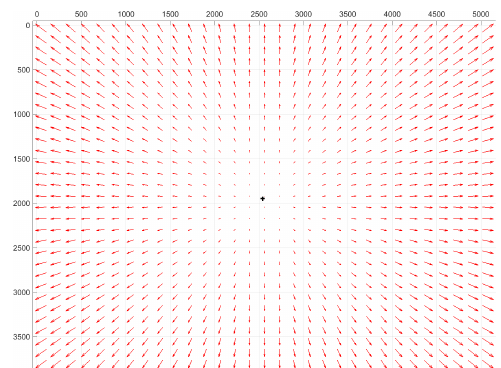
Figure 6. In red : the homothetic error centered on PP as shown in Figure 5. In dashed blue : the variation of camera distortion correction. The same plotting conventions as in Figure 5 are